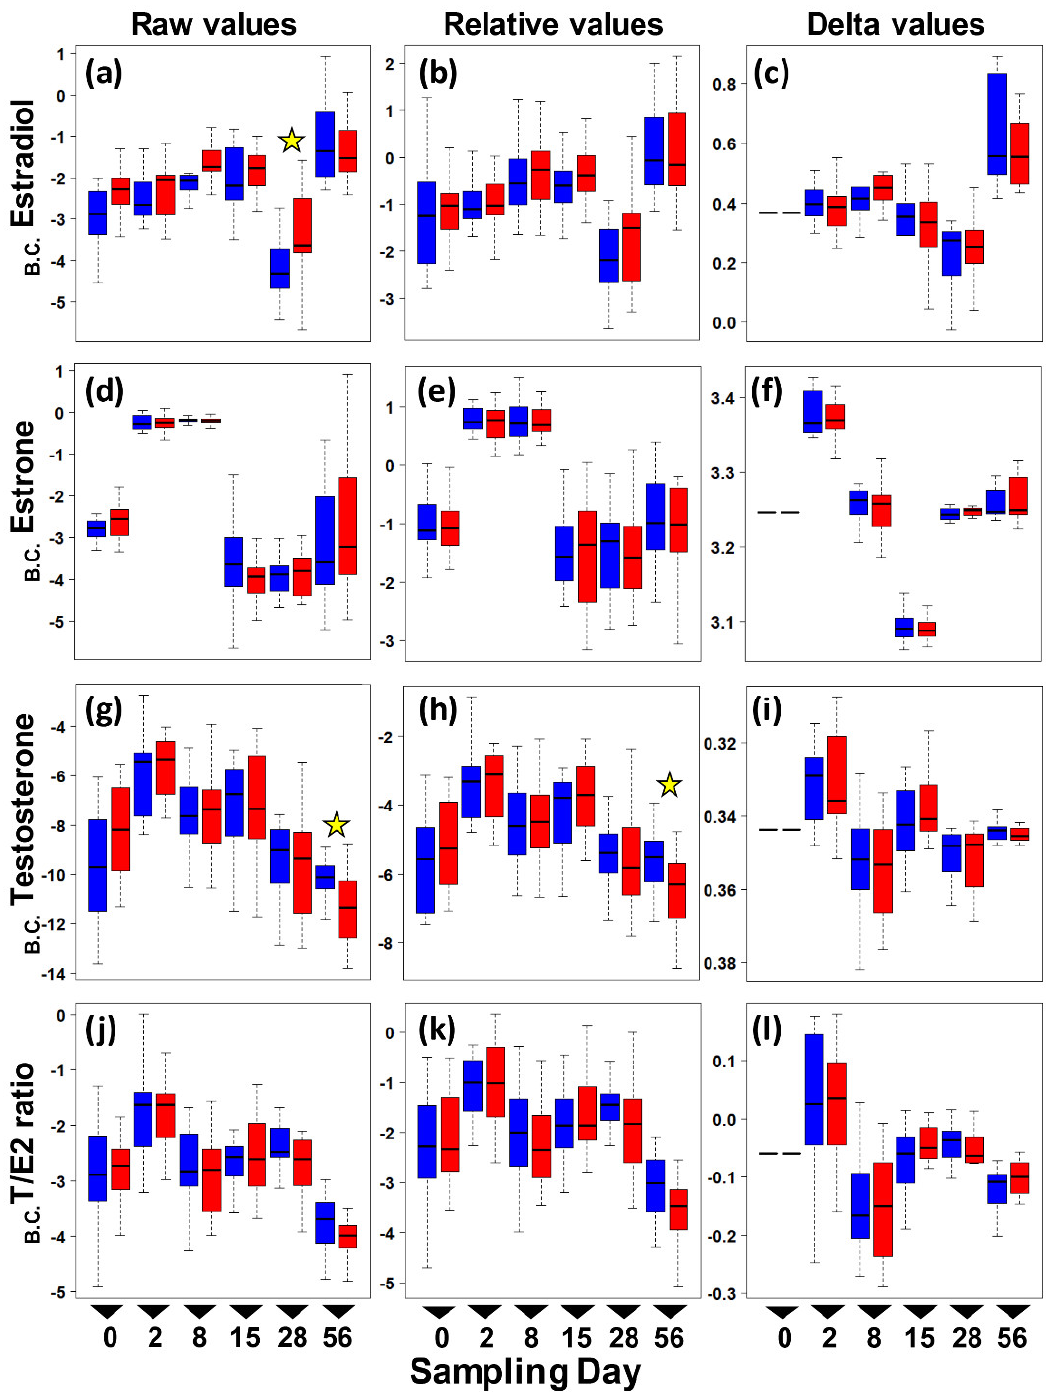
Figure 1. Boxplots of circulating sex hormone levels in adult female painted turtles ( Chrysemys picta ) after 0, 2, 7, 14, 28, and 56 days of exposure to colder (21 °C—blue) or warmer (26 °C—red) water temperatures indoors. Each boxplot denotes the interquartile range (IQR) with median values (black solid horizontal line), 25th to 75th percentile (box), and 1.5 IQR (dotted line whiskers) for Box–Cox transformed (B.C.) pg/mg values (no outliers were removed from these plots). Left panels present raw E2 ( a ), E1 ( d ), T ( g ), and T:E2 Ratio ( j ) levels. Middle panels present relative E2 ( b ), E1 ( e ), T ( h ), and T:E2 Ratio ( k ) levels. Right panels present changes from day 0 in E2 ( c ), E1 ( f ), T ( i ), and T:E2 Ratio ( l ) levels (i.e., delta values). Stars denote significant thermal effect on hormone level detected by separate ANOVAs conducted at each sampling day.